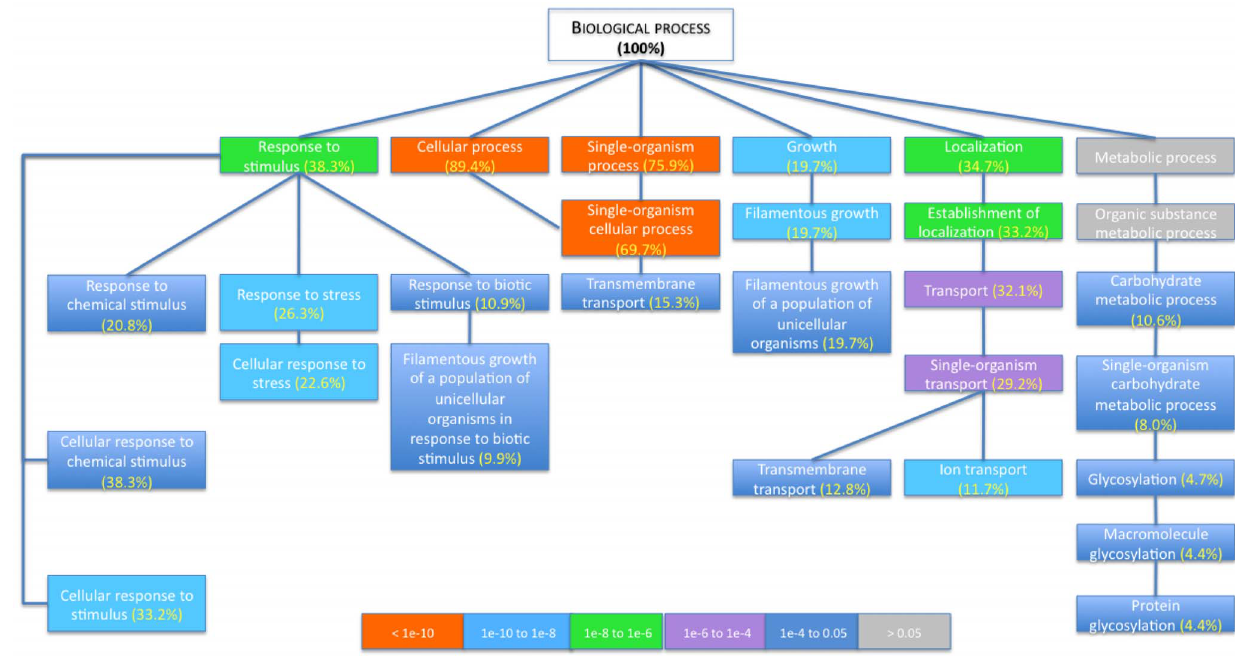
Figure 2. Hierarchical ranking of the GO Term Finder Process categories that were significantly enriched. Only categories that are significantly enriched (p , 0.05) are presented, except for those labeled grey added for hierarchical purposes. Subcategories with more than 2 higher rank categories that were not significantly enriched are not included in this figure (i.e., dicarboxylic acid transport and copper ion transport). For clarity purposes, categories with more than one connector are not presented, if the connecting category/categories was/were not significantly enriched. Color codes indicate p-values.